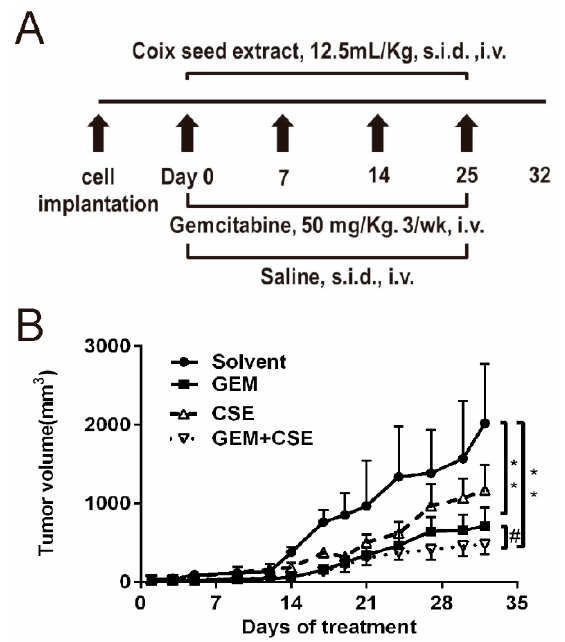
Figure 3. Coix seed extract enhances the antitumor e ff ect of gemcitabine in xenograft nude mice implanted with BxPC3 luc cells. ( A ) Brief presentation of in vivo experimental protocol. ( B ) Average tumor volume of solvent and di ff erent drug treatment groups was determined every three days after the first administration until day 32. n = 6, mean ± SD. ** p < 0.01 vs. solvent group; # p < 0.05 vs. gemcitabine alone group.